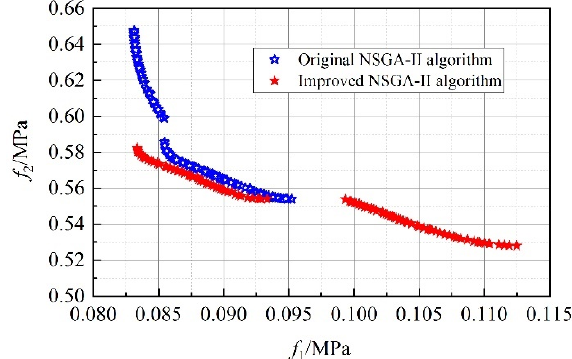
Figure 19. Comparison of the Pareto optimal solution set.